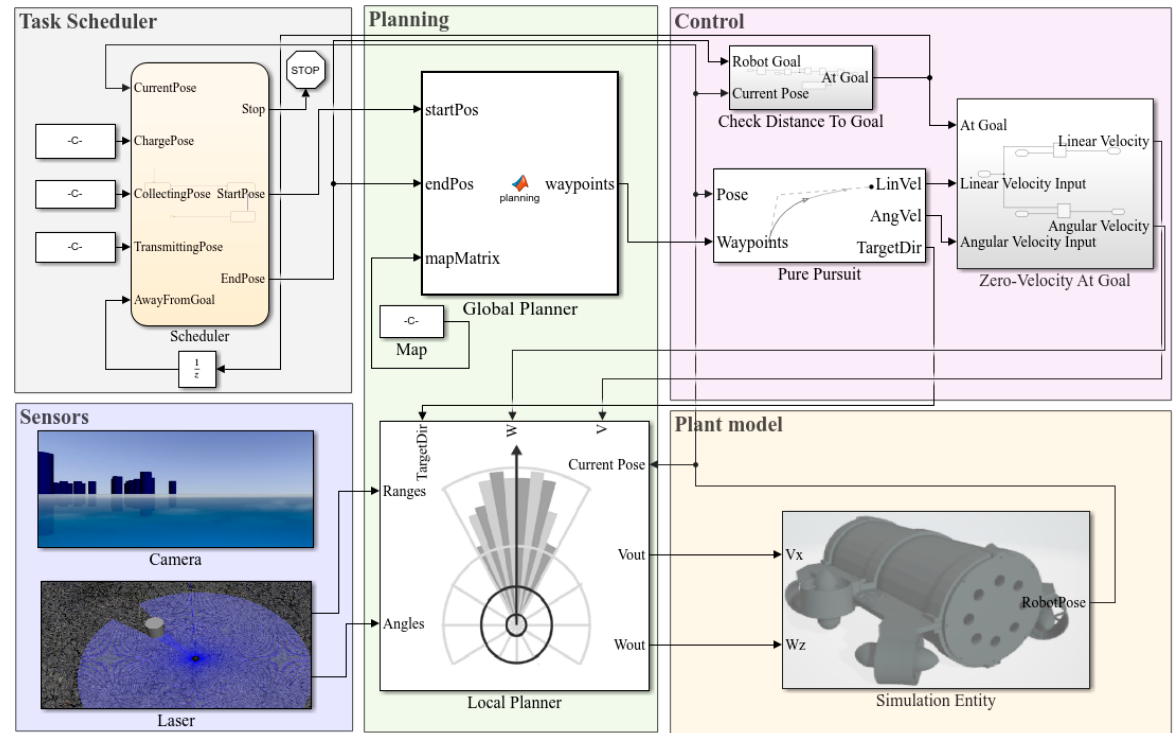
Figure 7. The comprehensive high-level planning template in Matlab/Simulink.